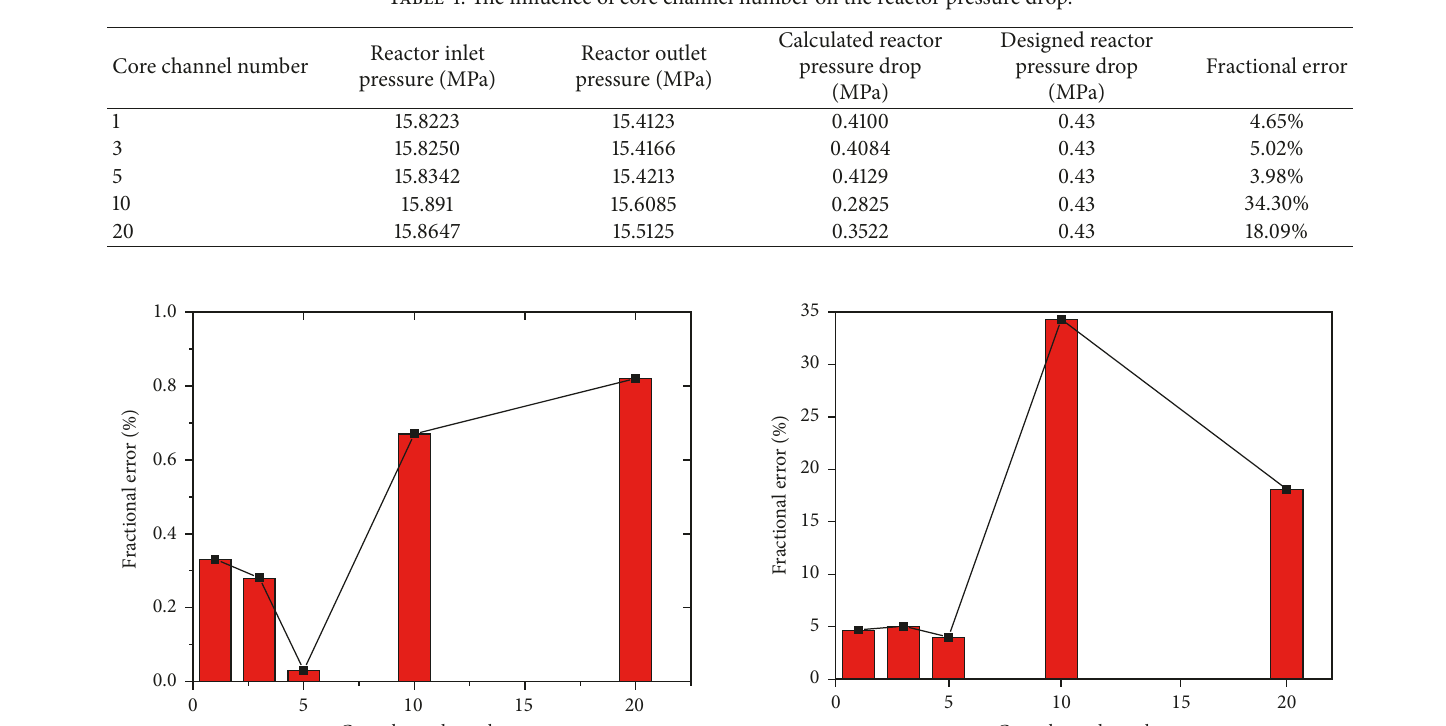
Table 4: The influence of core channel number on the reactor pressure drop.